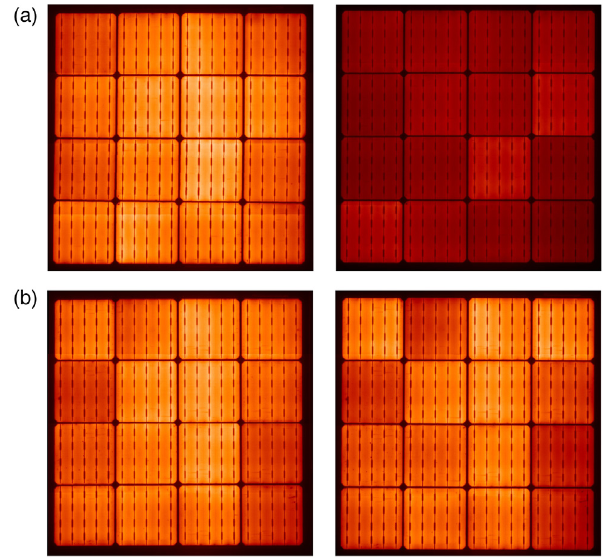
Fig. 12. Electroluminescent (EL) test results after 500 h DH for two out of the six modules that underwent DH tests. (a) EL test results at t 0 (left) and after 500 h DH (right) for the worst module manufactured with Cooling Press. (b) EL test results at t 0 (left) and after 500h DH (right) for the worst module manufactured without Cooling Press.